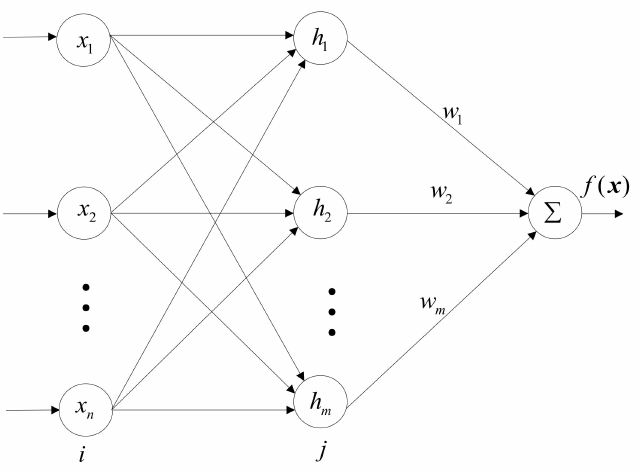
Figure 2. Structure of